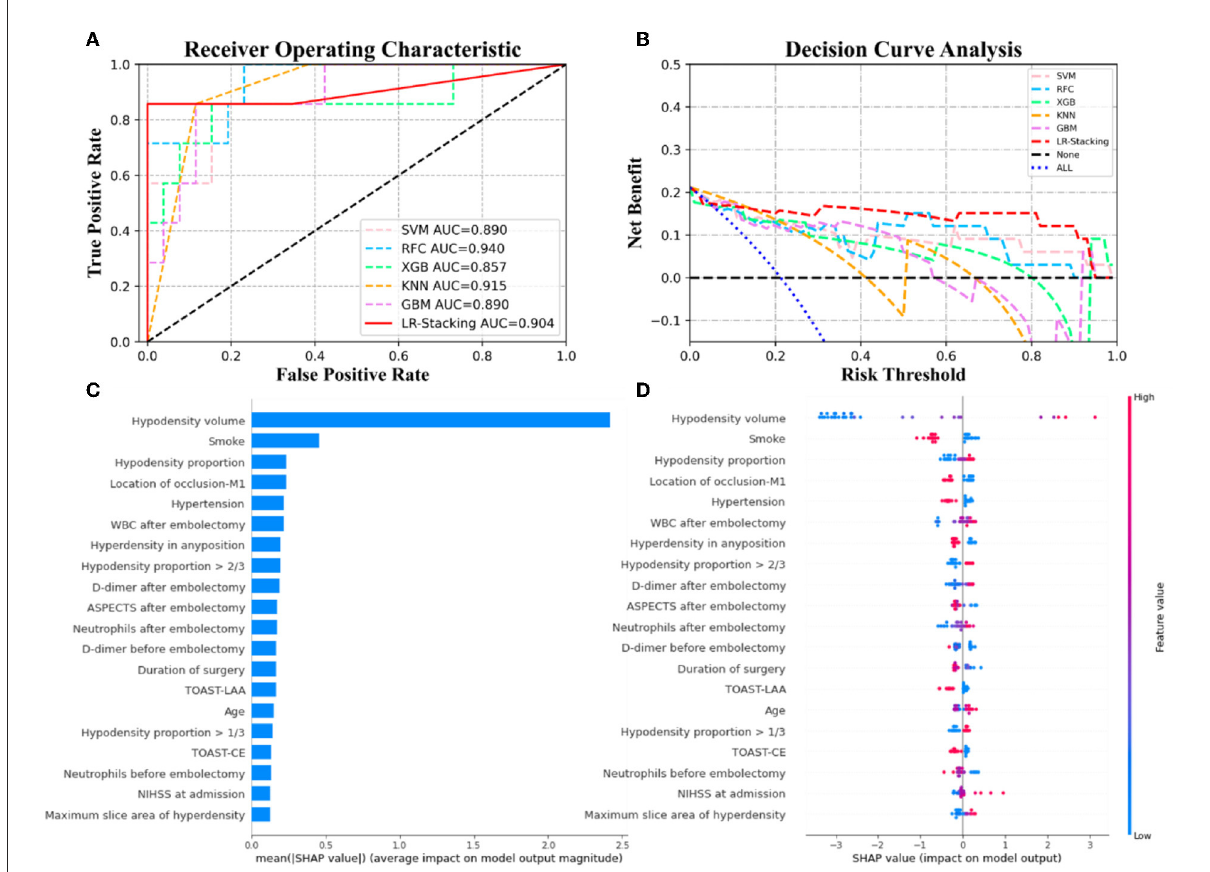
FIGURE5 The results of the ML models and contributions of various features to predicting CH. (A) The ROC curve of five ML models and LR-Stacking model. (B) The net benefit of the various models. (C) The importance of the features for the LR-Stacking model. (D) The effects of the features on the predictions of the LR-Stacking